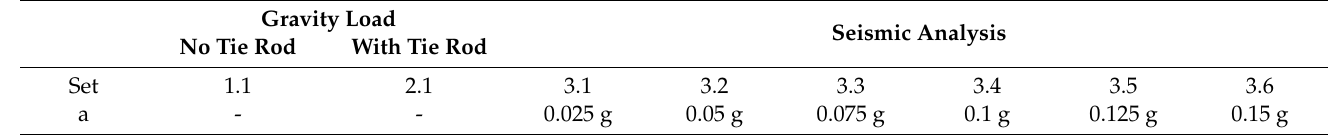
Table 11. Acceleration values associated with the different analysis sets.